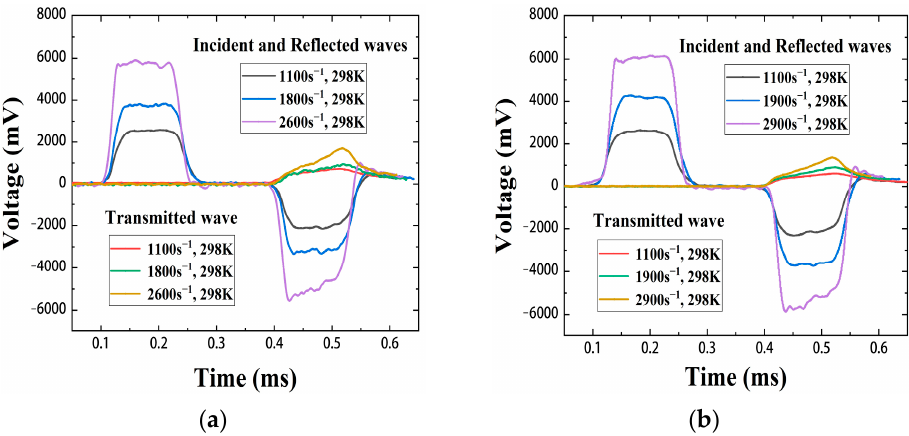
Figure 3. Stress-strain curves of Zr/PTFE, Ti/PTFE under quasi-static compression. ( a ) Zr/PTFE, ( b ) Ti/PTFE.